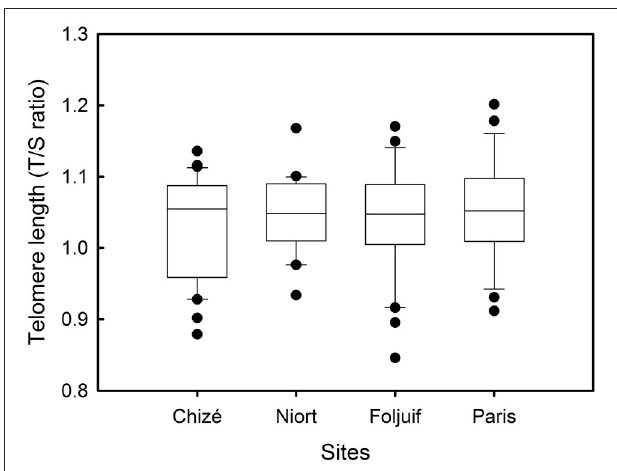
FIGURE 3 | Variation of telomere length among breeding sites in great tit nestlings reared in Chizé (woodland) and Niort (urban), Foljuif (woodland), and Paris